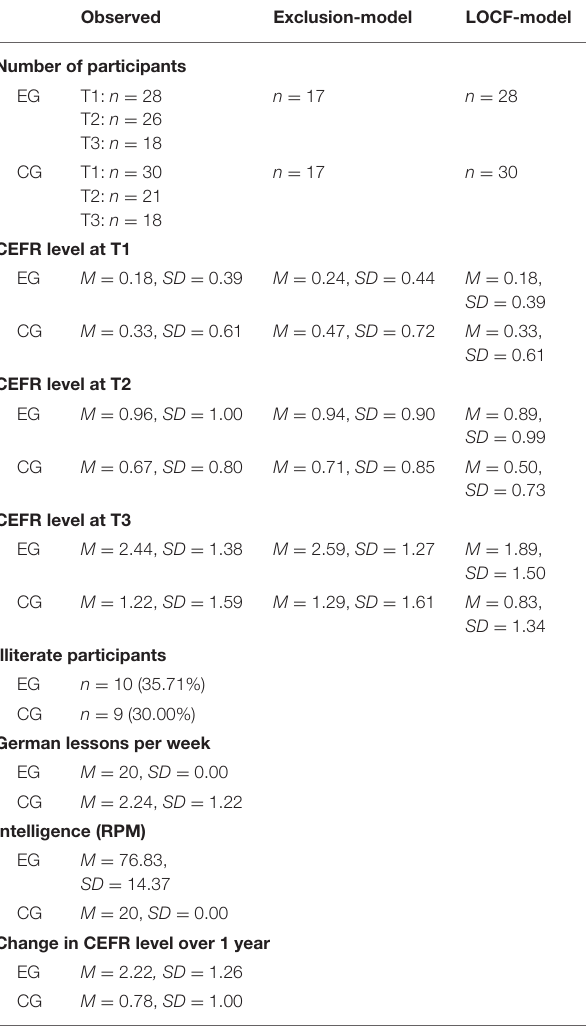
TABLE 4 | Mean values ( M ), median ( Md ) and standard deviations ( SD ) for the examined variables in the dropout analysis of the experimental group (EG) and control group (CG).